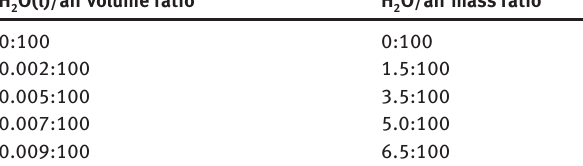
H 2 O(l)/air volume ratio